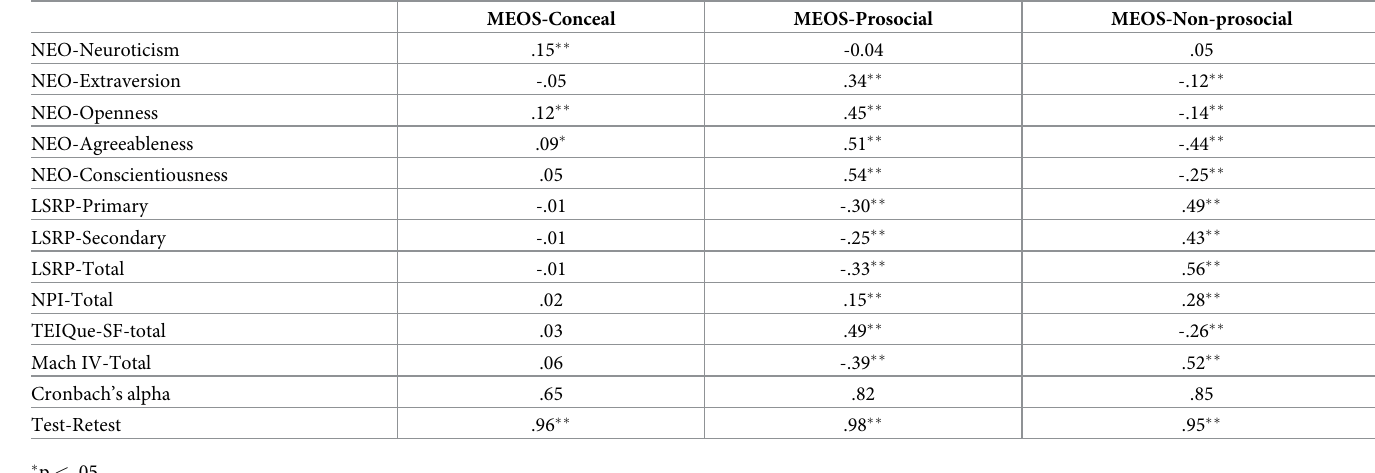
Table 6. Internal reliability and the bivariate correlations between MEOS-SF and other